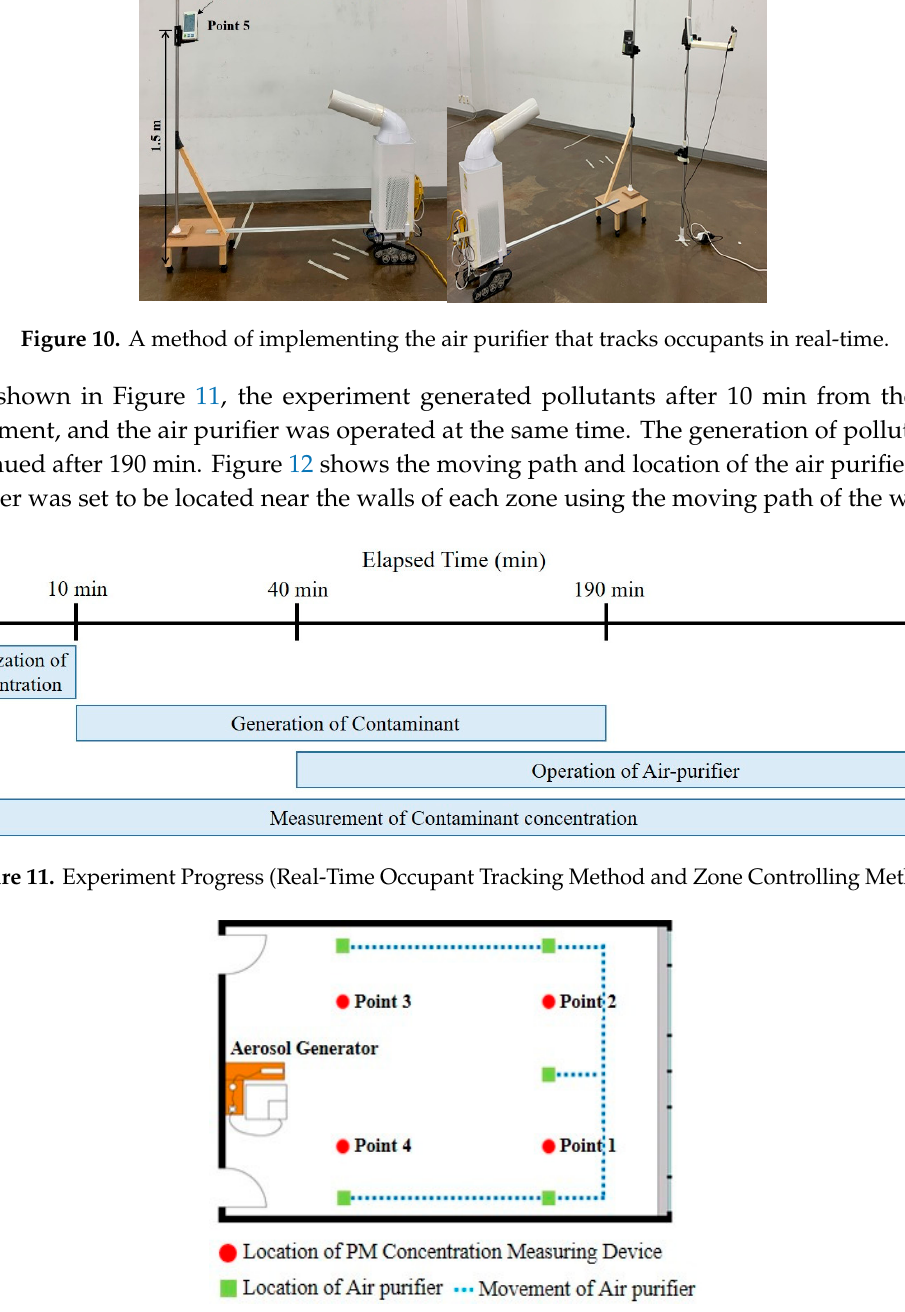
Figure 10. A method of implementing the air purifier that tracks occupants in real-time.